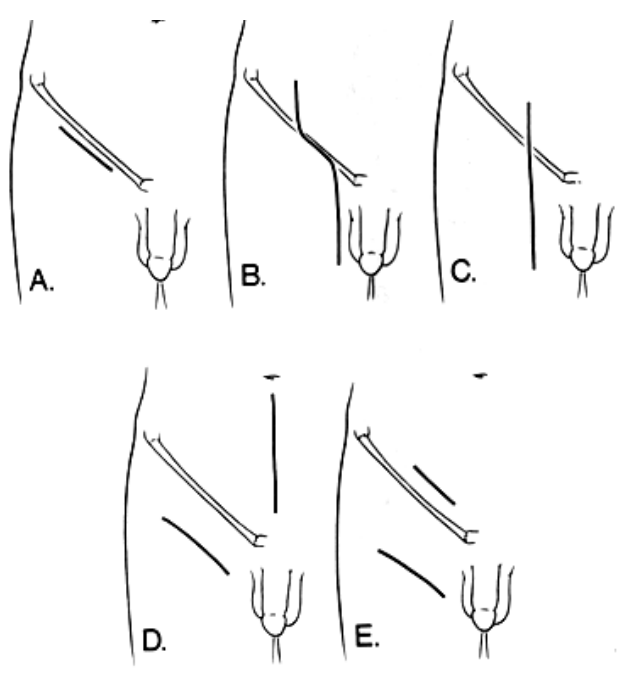
FIGURE 3 . Incisions for radical inguinal lymphadenectomy. Single incision approaches: A) oblique, B) S-shaped, C) vertical, D) double incision; lower midline and inguinal, E) for unilateral pelvic lymphadenectomy, oblique abdominal incision combined with inguinal